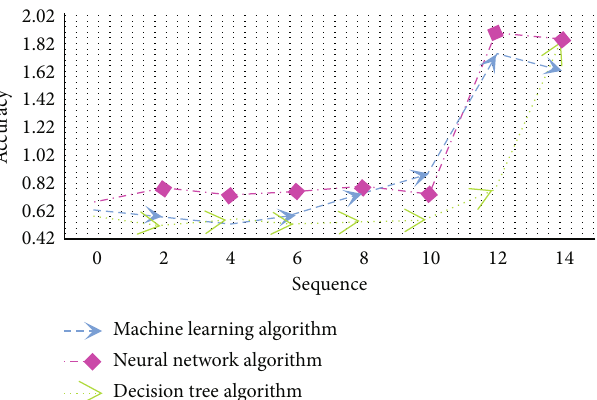
Figure 7: Comparison of accuracy of three